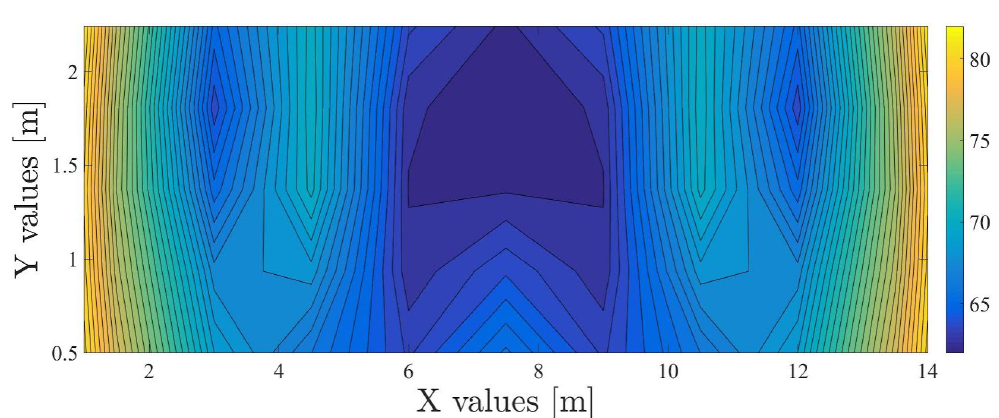
Figure 12. Mapping of the static force as a function of the impact position on the net (kN) for an impacting energy E M , ini of 270 kJ.